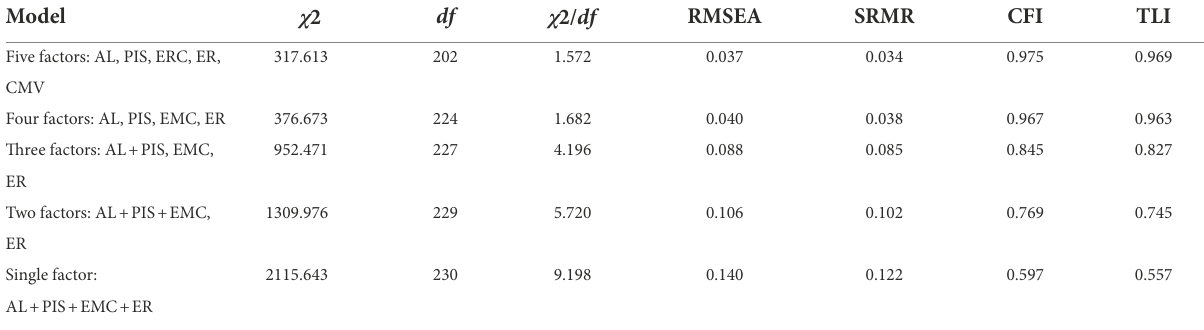
TABLE 1 Confirmatory factor